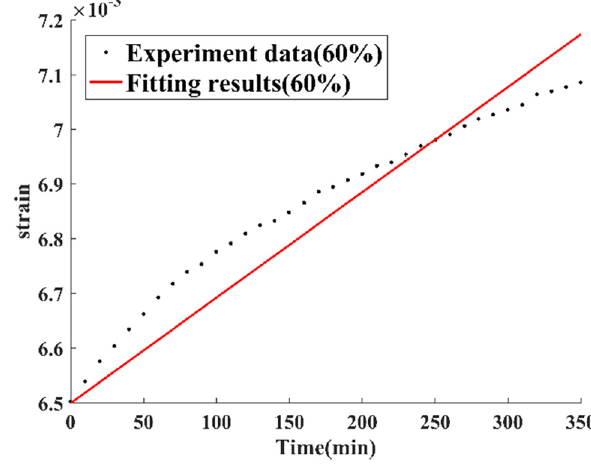
Figure 9: Fitting results based on the conventional Maxwell model and 40% stress level.